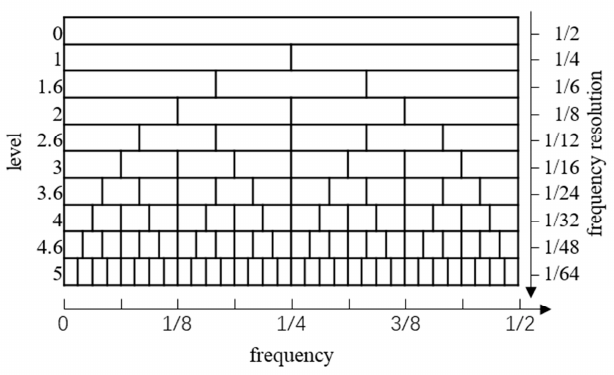
Figure 1. 1/3-binary tree filter bank.